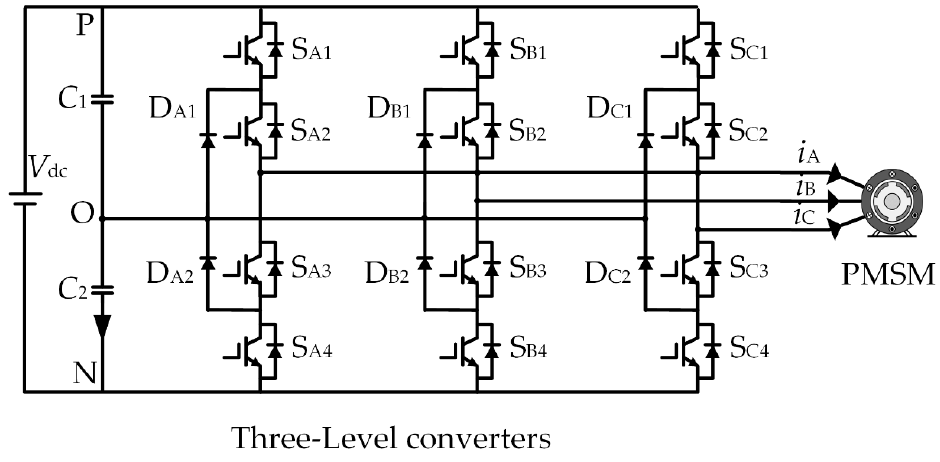
Figure 1. NPC three-level converter fed PMSM system. The switching states and output voltages of each phase are shown in Table